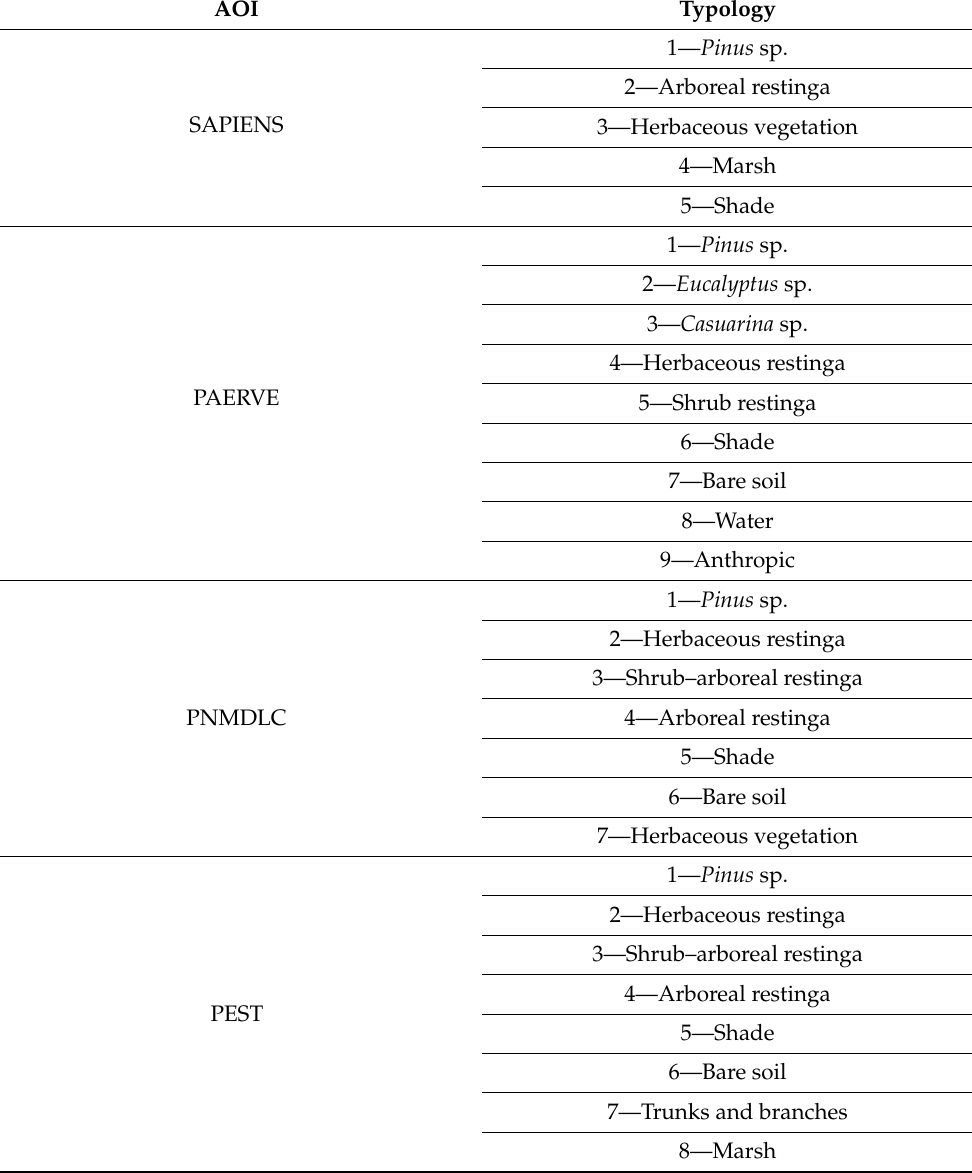
Table 1. Number of classes and typologies by area of interest (AOI). AOI Typology